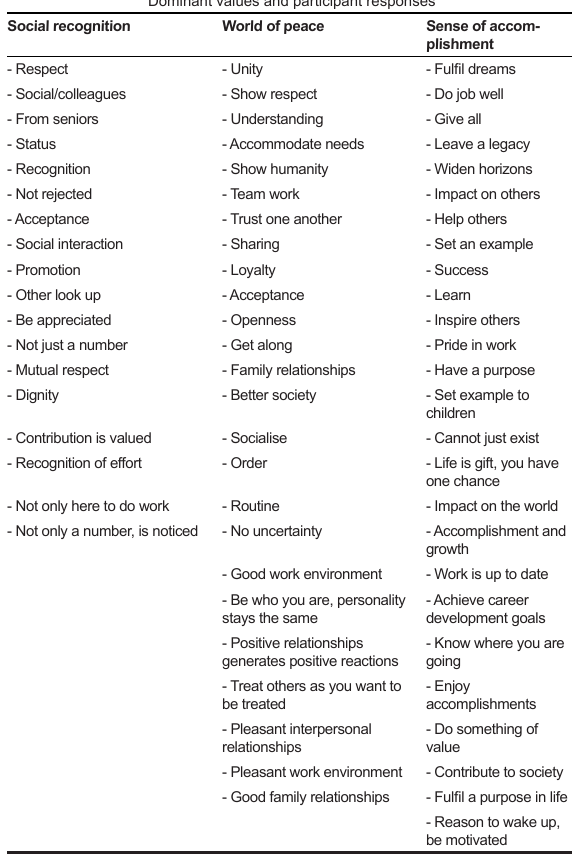
TABLE 2 Dominant values and participant